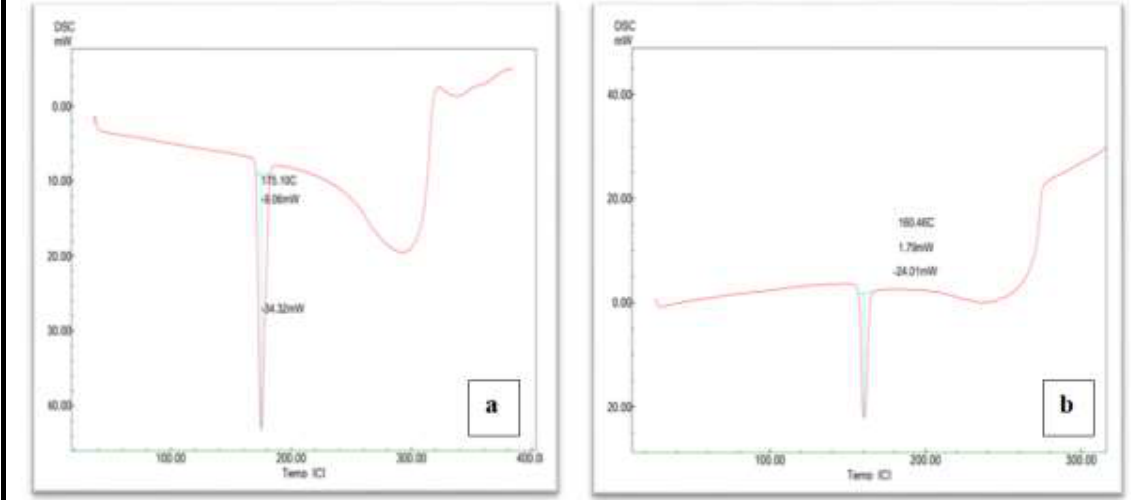
Figure 10. DSC of paracetamol (a) and naproxen (b).